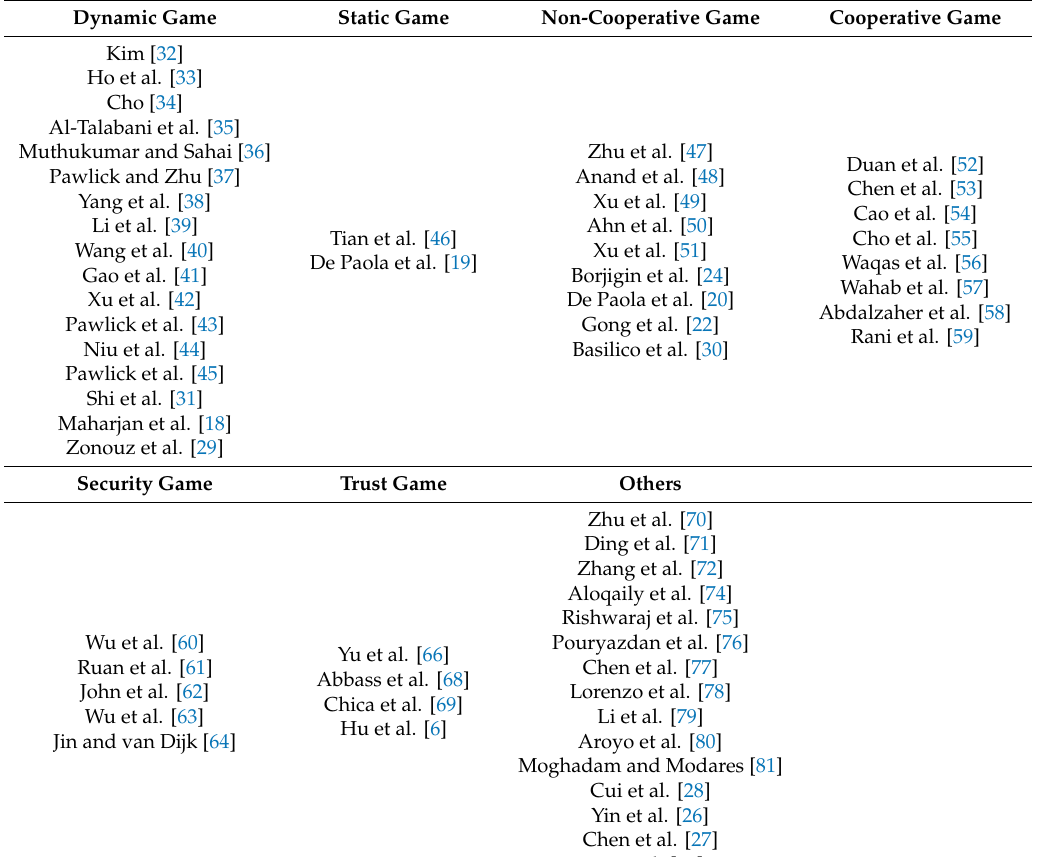
Table 1. Examples of games based on their